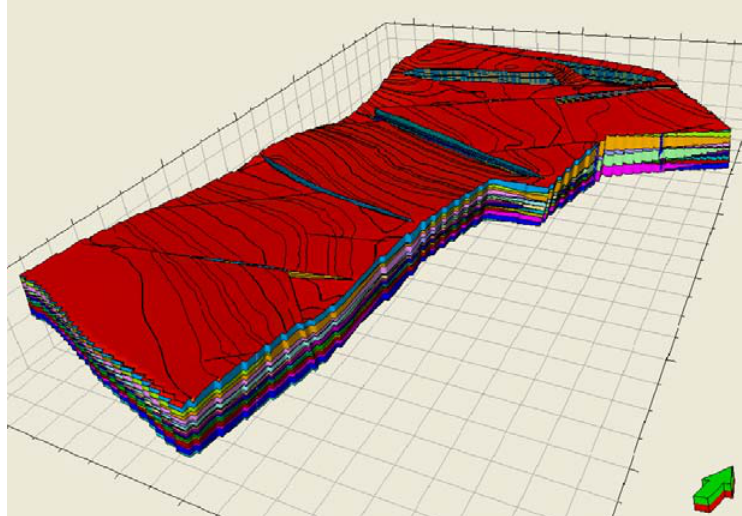
Figure 2. Structural model of bituminous coal seams.